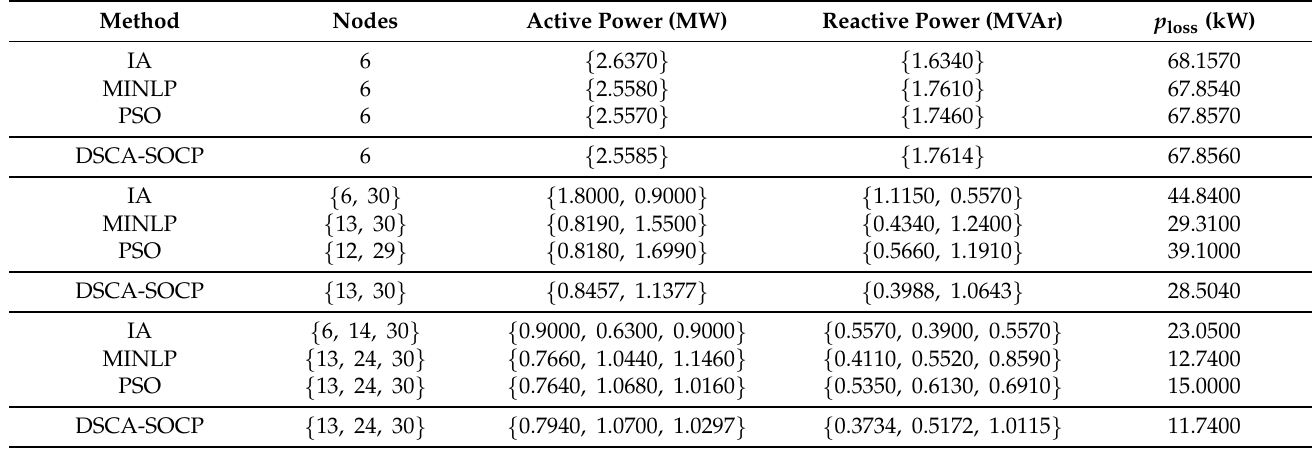
Table 4. Optimal location and sizing of the DGs considering variable power factor capabilities in the 33-node test feeder.